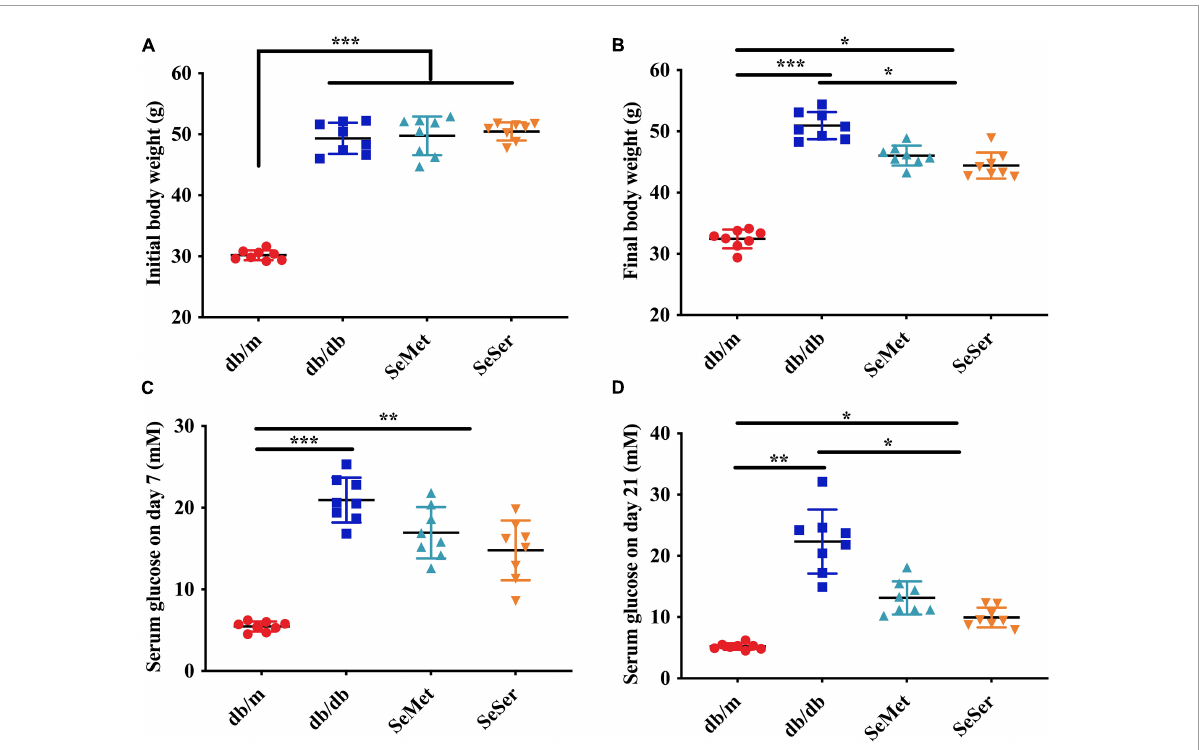
FIGURE1 Administration of selenomethionine and serine decreased body weight and serum glucose level in db/db diabetic mice. (A) Initial body weight; (B) final body weight; (C) serum glucose level on day 7; (D) serum glucose level on day 21. Values are expressed as mean ± SEM, n = 8. * P < 0.05, ** P < 0.01, *** P < 0.001.